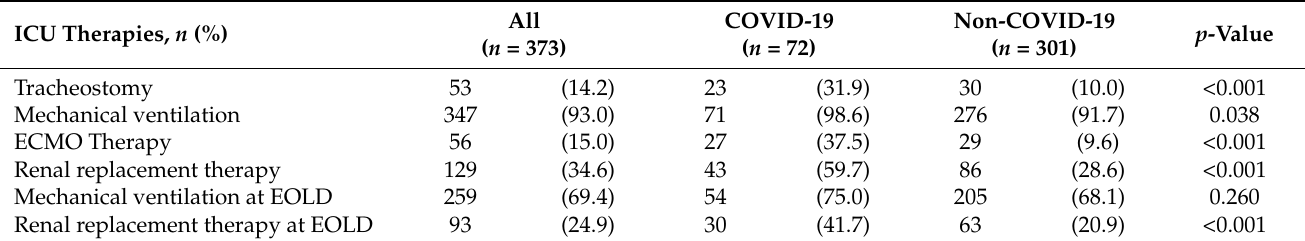
Table 3. ICU Therapies.